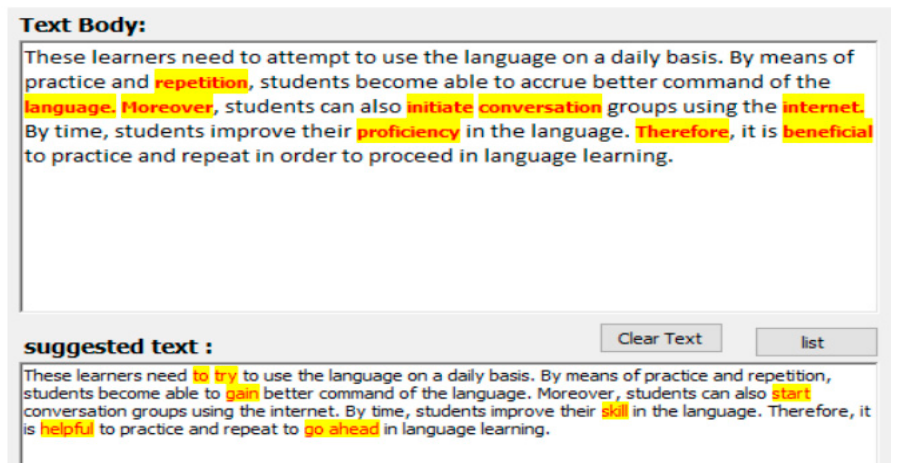
Figure 8. Example of using a local database for the replacement of the terms .